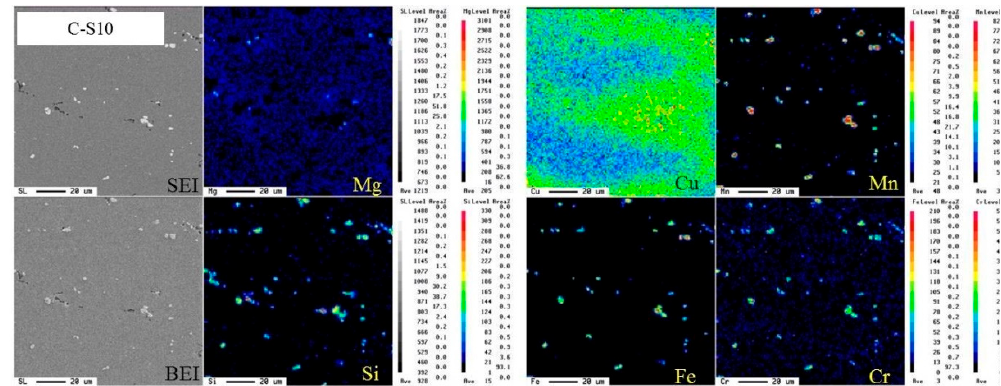
Figure 9. Elemental distribution of compressed TS ‐ SIMA alloy (C ‐ S) obtained using EPMA.